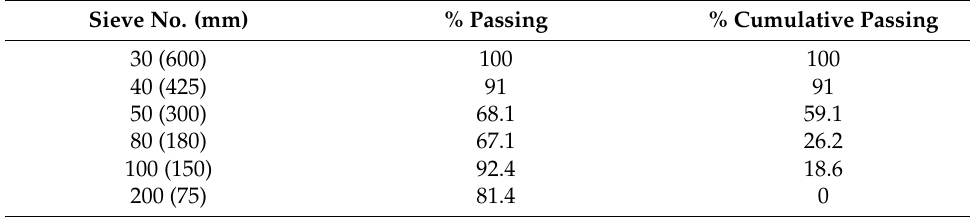
Table 2. Gradation of Normal CRM.